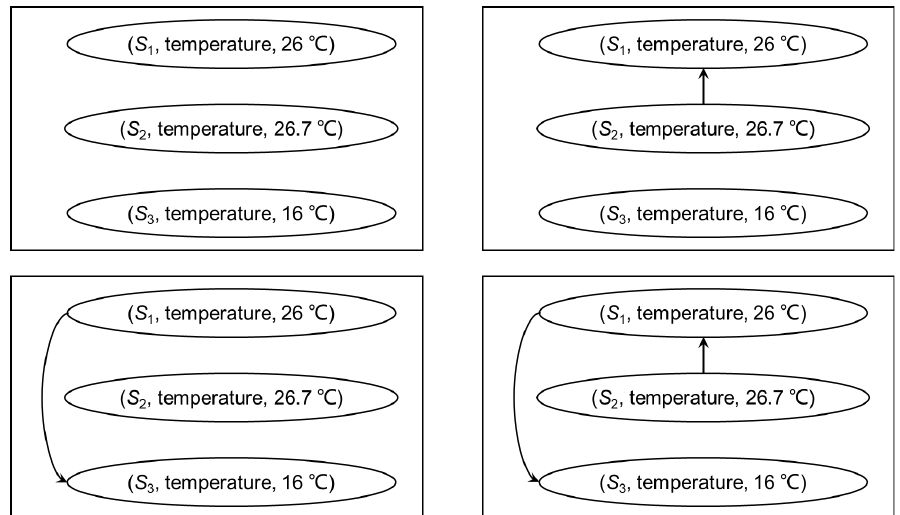
Figure 3. The possible worlds of a quality